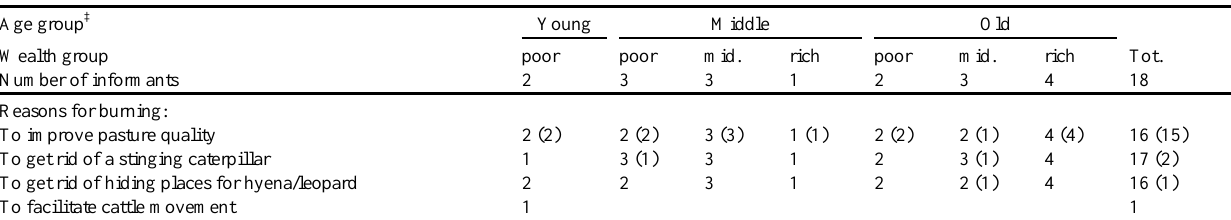
Table 2 . Stated reasons † for burning, separated by age and wealth groups. Age group ‡ Young Middle Old Wealth group poor poor mid. rich poor mid. Tot. Number of